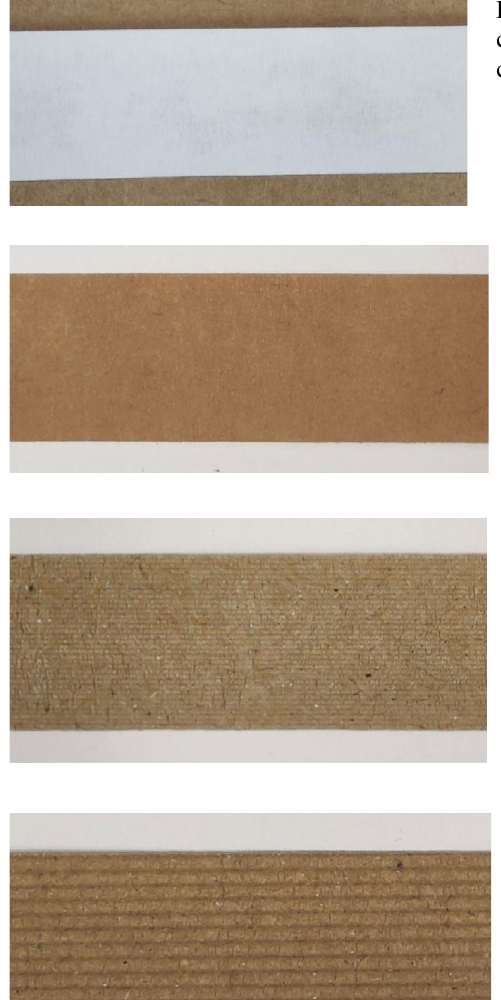
Fig. 14 15 mm wide sample of paper A